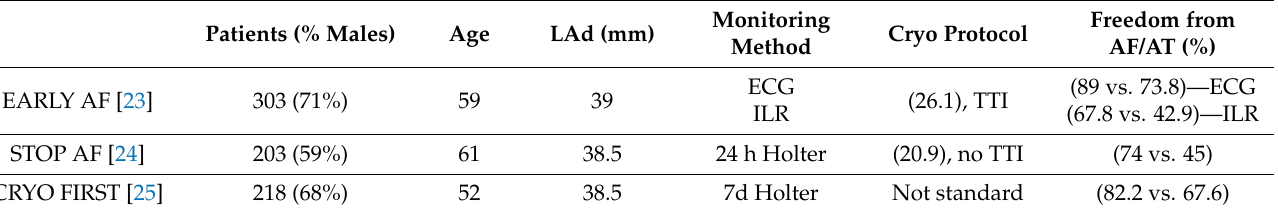
Table 1. The three randomized clinical trials showing superiority of pulmonary vein isolation with cryoballoon over antiarrhythmic therapy for prevention of recurrence in patients with paroxysmal atrial